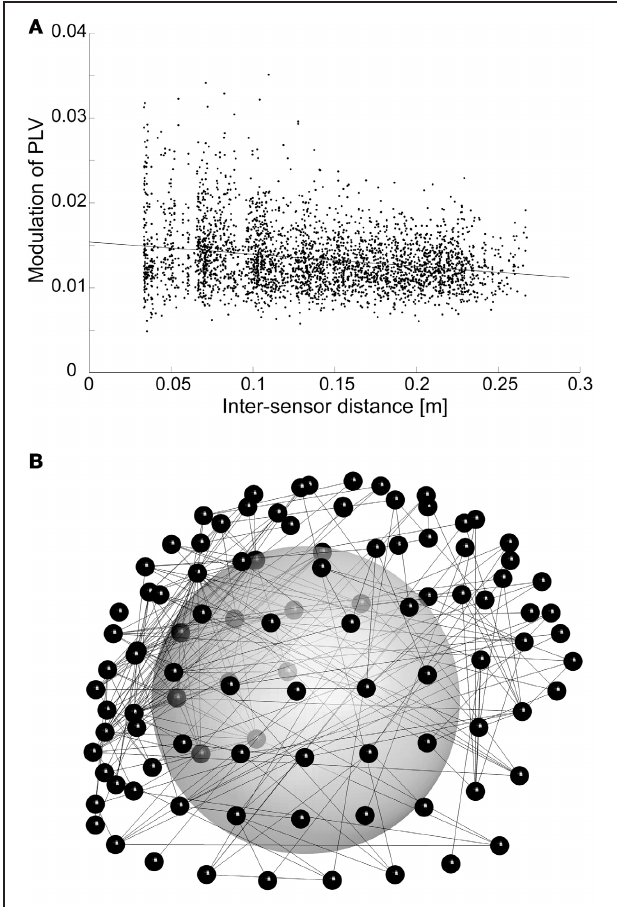
FIGURE 4 | (A) The modulation of PLV among higher-frequency (17Hz) oscillations by the phase of an oscillation at lower frequency (4Hz) is plotted against inter-sensor distance. This subject and frequency pair was selected, because it had the strongest correlation between distance and nested synchrony strength. For clarity, we visualize only those nested synchrony data that are significant and have adjusted R 2 goodness-of-fit higher than 0.75 (3418 data points). (B) Spatial visualization of the data in (A) , but with R 2 -criterion of 0.9 (308 connections). The connections (lines) are depicted between sensors (small spheres) that are visualized in their 3D positions. The large sphere demonstrates the head inside the MEG helmet; the occipital pole is in the lower left corner, nose pointing to the